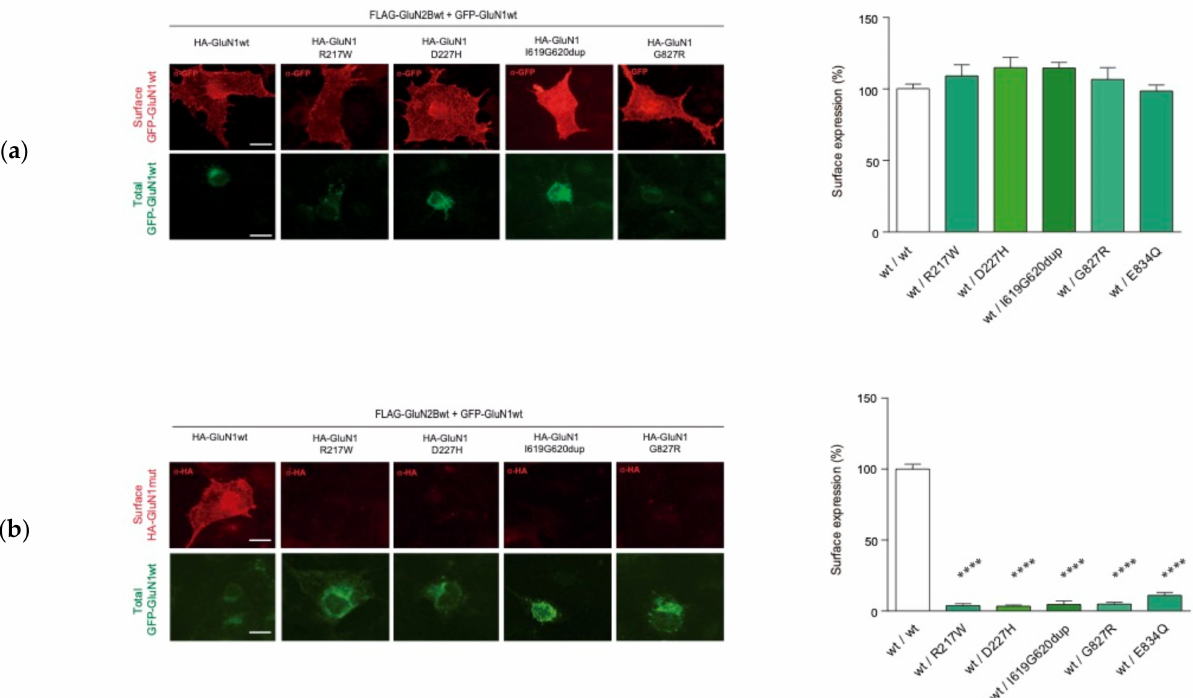
Figure 4. Analysis of intermolecular GluN1 wildtype and mutant interaction effects on NMDAR surface expression. ( a ) Left , Representative image of immunofluorescence analysis of GFP-GluN1-wt surface expression in COS-7 cell line co-transfected with GFP- GRIN 1-wt, HA- GRIN1 -DNV and Flag-GRIN2B-wt; scale bar: 10 µ m; Right , Bar graphs representing the mean ± SEM of cell surface expression of NMDAR (N = 16–38 cells per condition, from 3–4 independent experiments; ns, p -value > 0.05; **** p -value < 0.0001, one-way ANOVA with Bonferroni’s post hoc test). ( b ) Left , Representative image of immunofluorescence analysis of HA-GluN1(wt/mutant) surface expression in COS-7 cell line co-transfected with GFP- GRIN1 -wt, HA- GRIN1 -DNV and Flag-GRIN2B-wt; scale bar: 10 µ m; Right , Bar graphs representing the mean ± SEM of cell surface expression of NMDAR (N = 16–38 cells per condition, from 3 to 4 independent experiments; ns p -value > 0.05; **** p -value < 0.0001, one-way ANOVA with Bonferroni’s post hoc